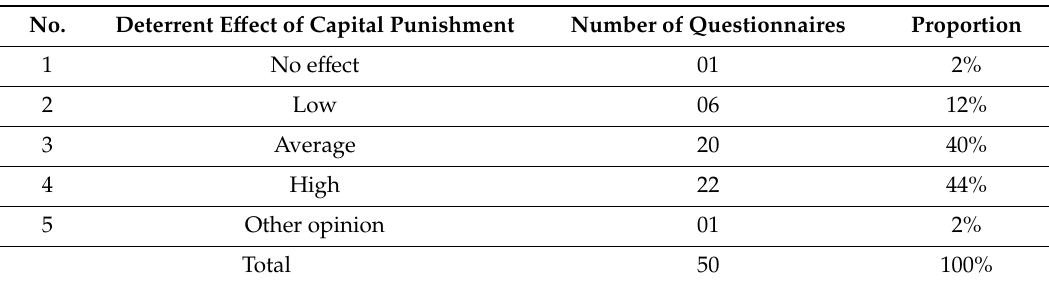
Table 8. Deterrent e ff ect of capital